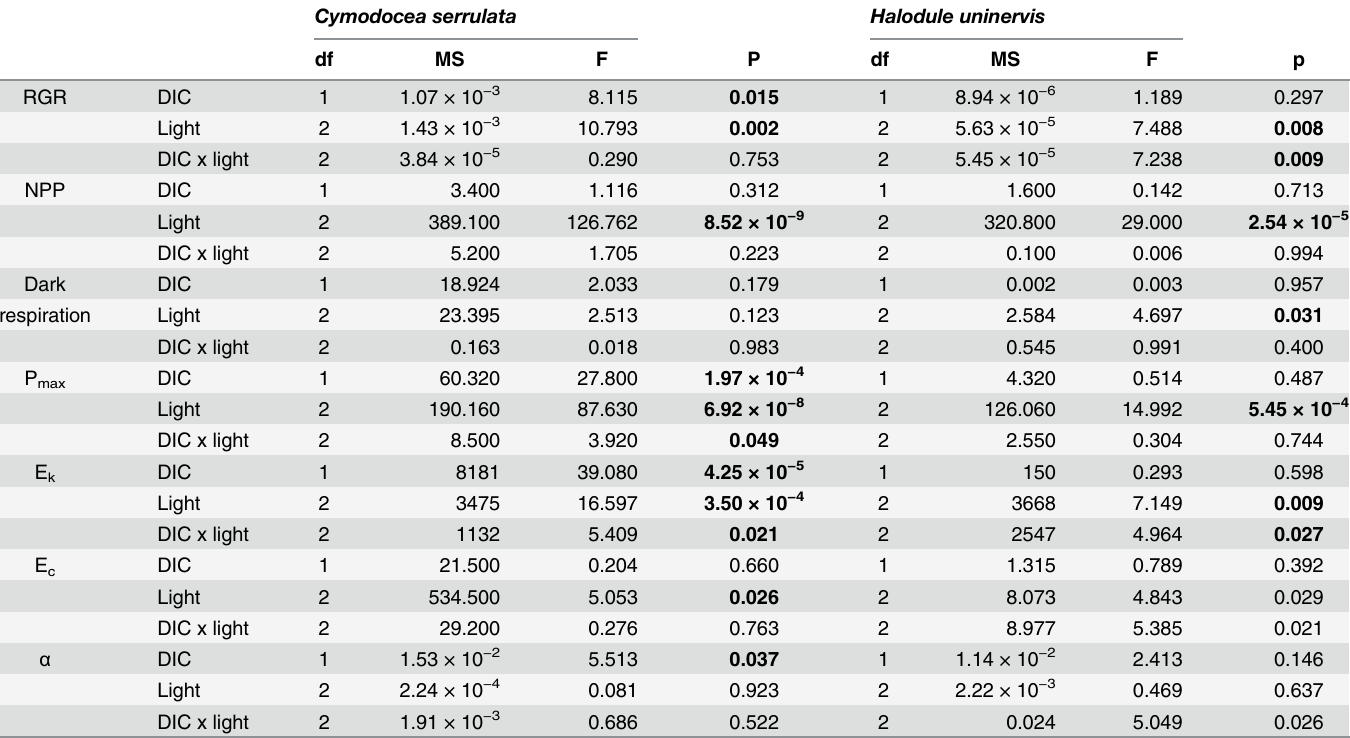
Table 2. Two-way ANOVA